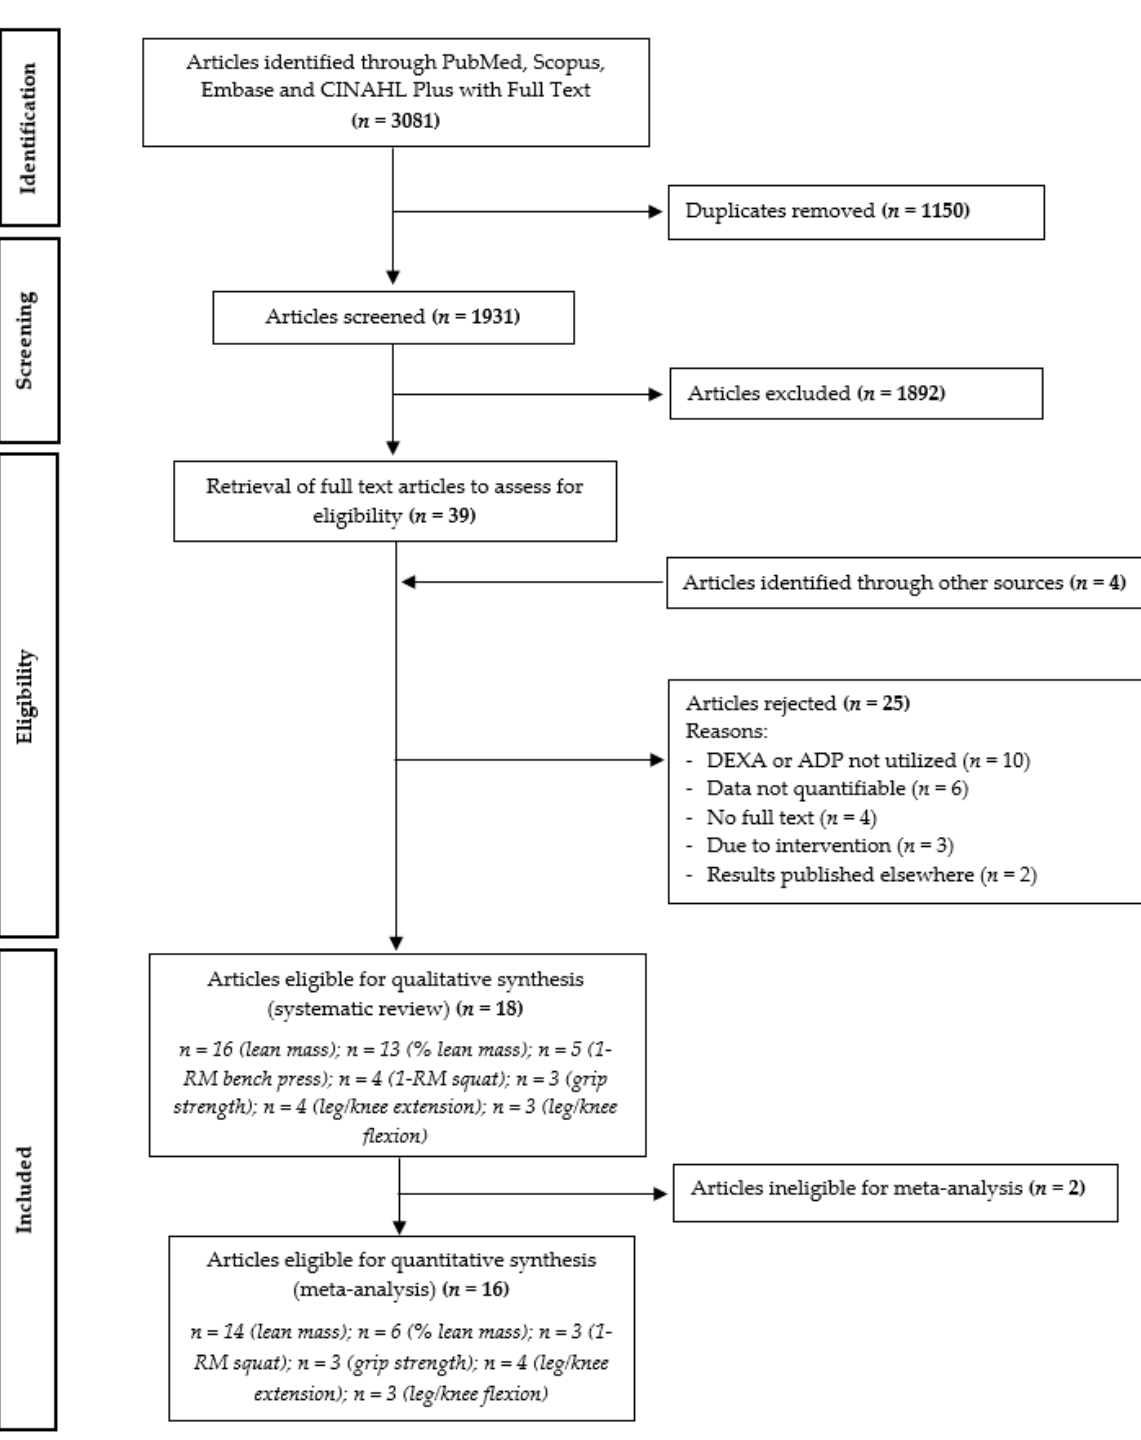
Figure 1. Preferred reporting items for systematic reviews and meta ‐ analyses (PRISMA) flow chart of the literature selection process. 1 ‐ RM: one ‐ repetition maximum.